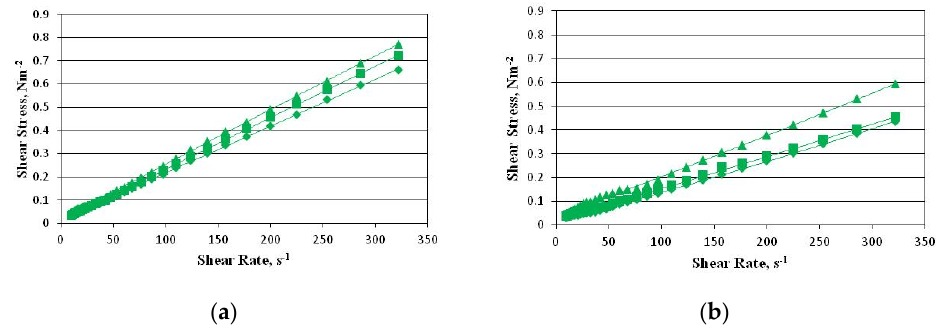
Figure 6. Examples of the flow curves of the model emulsions of HSO in water with Nebudose after 1 ( a ) and 7 ( b ) days: ◆ —1%; ■ —2%; ▲ —5 %.